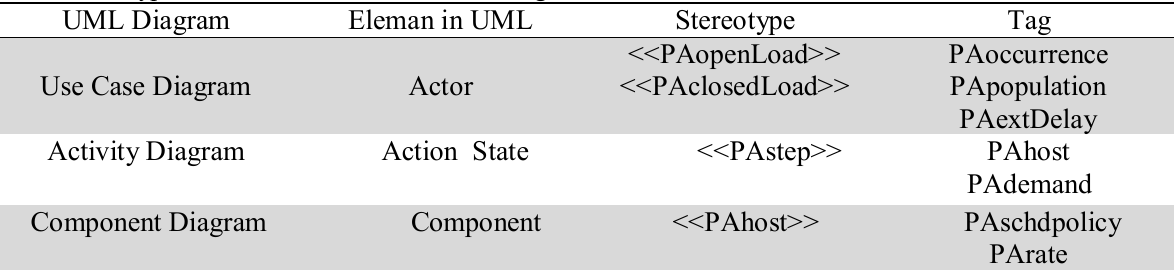
The stereotypes and the labels of the UML